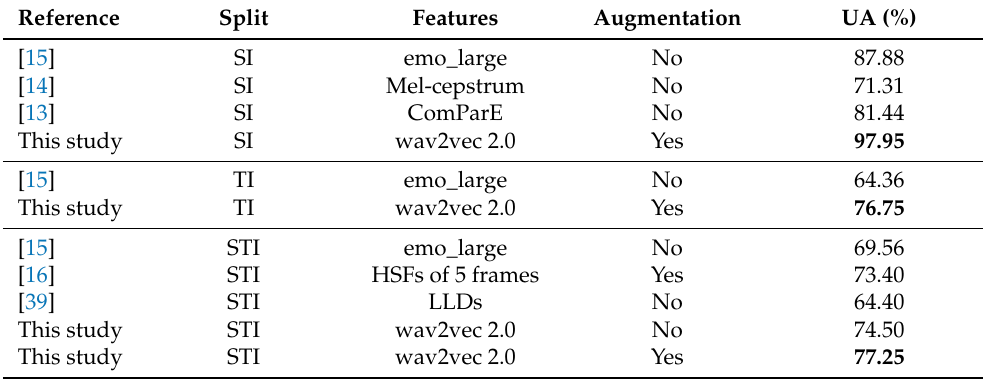
Table 6. Comparison of JTES performances (Unweighted Accuracy, UA). The highest scores for each split are in